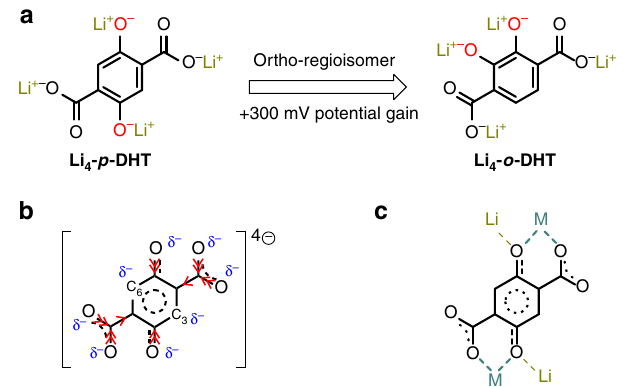
Fig. 1 Electronic effects and potential tuning. a Formal potential increase when switching from para- to ortho-regioisomer in Li 4 DHT 51 . b Limiting structure (hybrid) of the tetranionic p -DHT ligand together with partial charges (in blue). The red arrows conventionally indicate the donor inductive effect ( + I) related to both phenolate and carboxylate substituent groups. c Illustration of the chelating bonding mode between the tetranionic ligand and countercations based on crystallographic data reported for MOFs containing p -DHT as polytopic linker (i.e., Li + and a spectator cation M n + ); the nature of M − O bonds can affect the electronic distribution along the aromatic